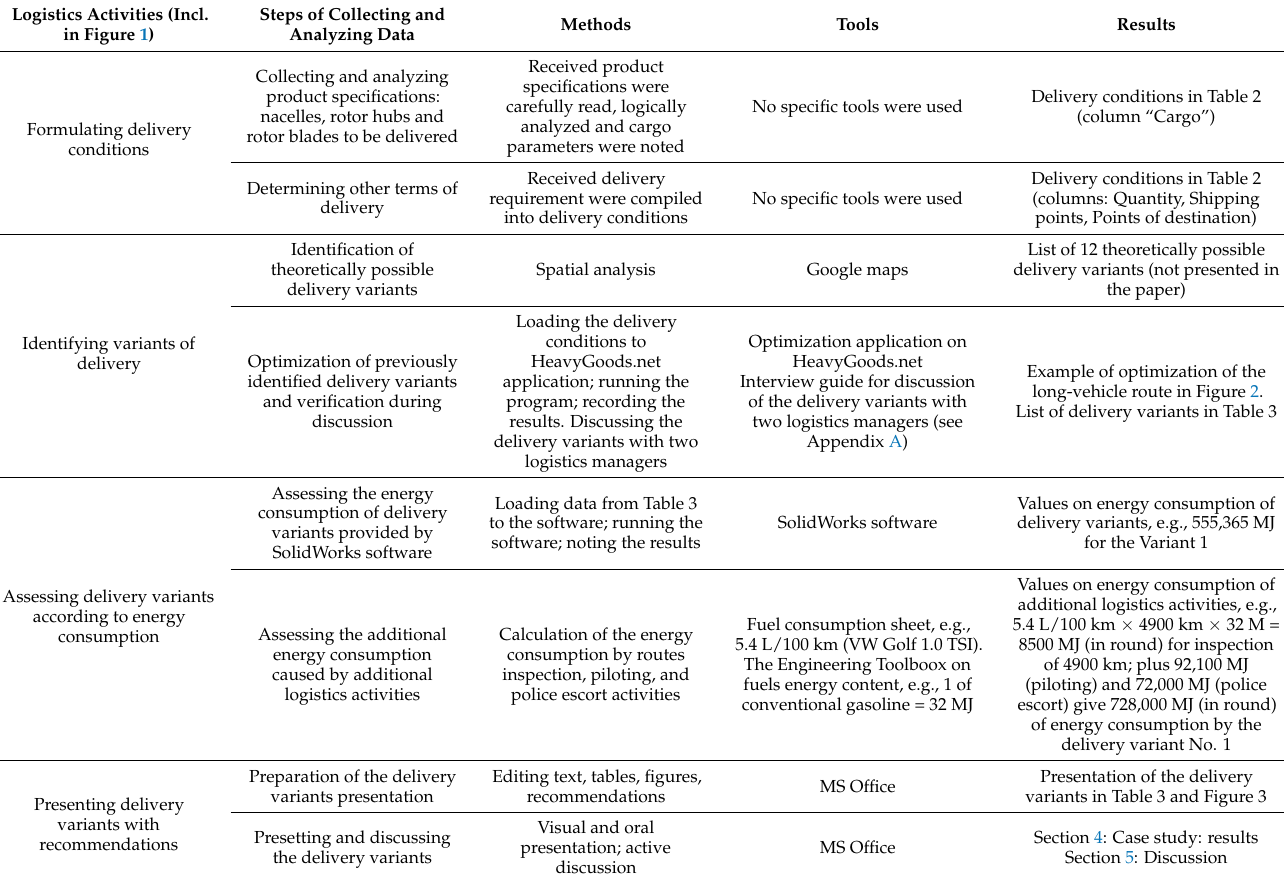
Table 1. Steps of collecting and analyzing collected data with relation to other